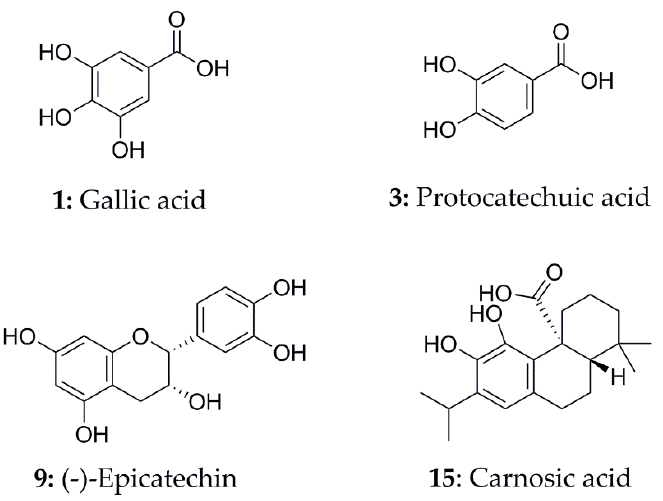
Figure 6. The potential ligands screened from EA fraction of A. indica by UF-LC-MS with superoxide dismutase (SOD) and xanthine oxidase (XOD).